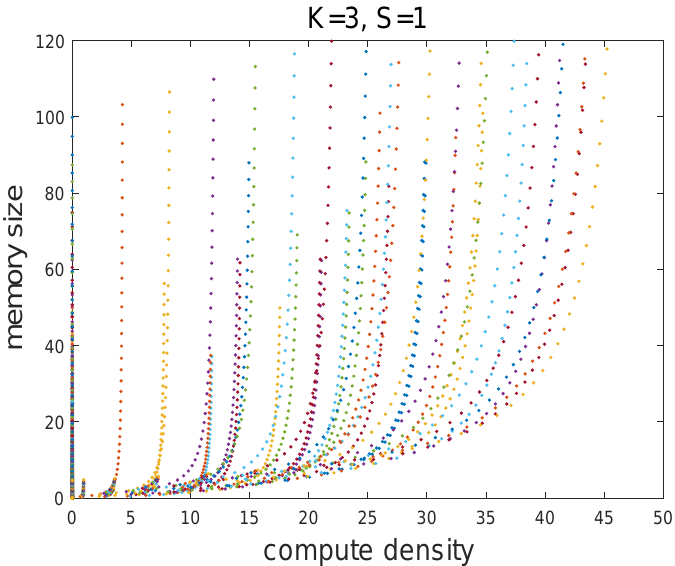
Figure 8. The relationship between memory and compute